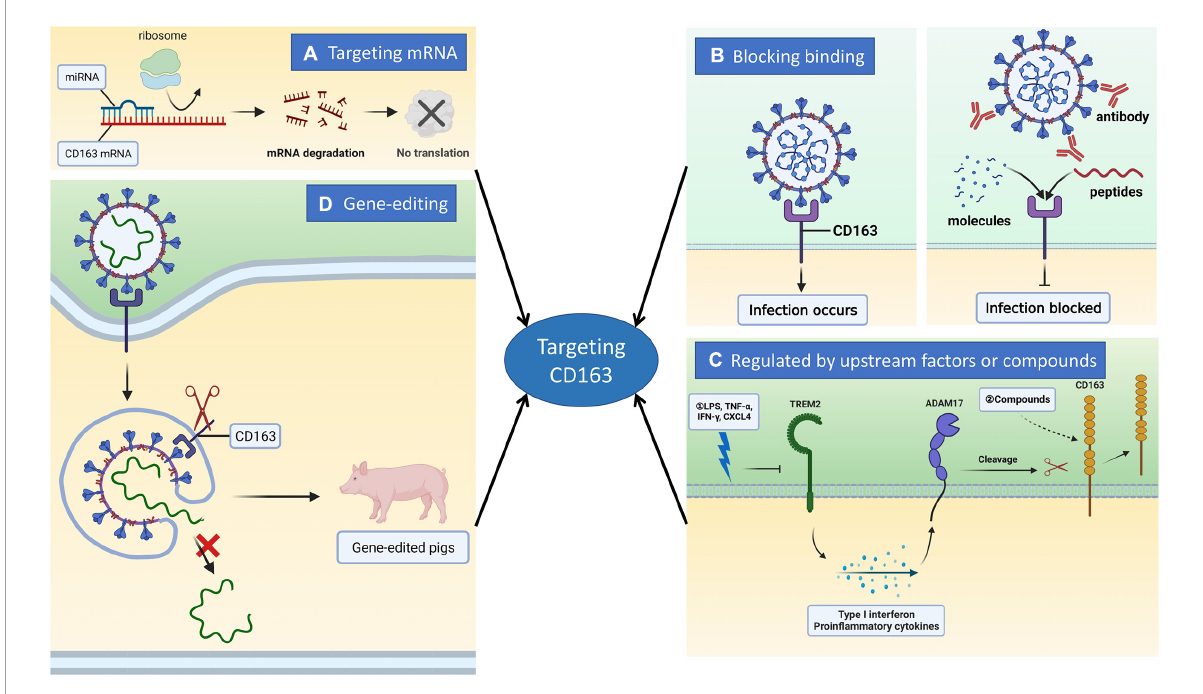
FIGURE1 Inhibition of PRRSV infection by targeting CD163 molecule through different strategies. CD163 is a major receptor for PRRSV infection of cells. It is very promising to prevent and control PRRSV via targeting CD163. Commonly there are four approaches to regulate CD163 expression. (A) miRNAs are capable of binding to CD163 mRNA to induce its degradation, ultimately blocking the translation of CD163 protein. (B) CD163 interacts with viral glycoproteins such as GP2, GP3, and GP4 to mediate virus uncoating and genome release. Based on it, small molecules, peptides and antibodies can disrupt the interaction between CD163 and virus glycoproteins to block uncoating thus suppressing PRRSV proliferation. (C) CD163 is involved in anti-inflammatory responses and several factors are reported to has the ability to regulate its expression. Upstream factors such as TREM2 and ADAM17 can regulate CD163 expression to modulate PRRSV infection. TREM2 silencing causes the activation of PI3K/NF- κ B pathway to boost the expression of pro-inflammatory cytokines. Therefore, the cleavage of CD163 molecule mediated by ADAM17 is occurred, ultimately restraining virus replication. Several compounds are also capable of modulating CD163 expression. (D) CD163 is an essential receptor for PRRSV. CRISPR/Cas9-mediated gene modification enables us to edit CD163 to construct genetically modified pigs. The reason why the animals show completely resistance to PRRSV infection is that the modified CD163 cannot bind to the virus glycoproteins thereby blocking